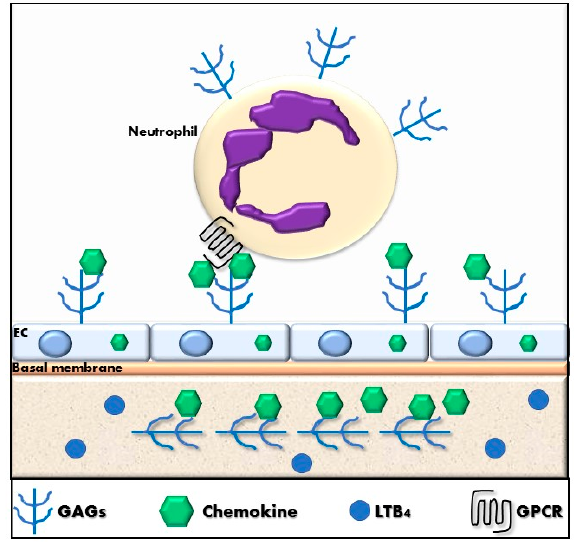
Figure 3. Neutrophil recruitment by chemokines and leukotriene B4. Neutrophils are recruited to the tissue through chemoattractants such as chemokines and LTB4. Chemokines bind to GAGs, which are expressed on endothelial cells and tissue. The retention of chemokines on GAGs generates a chemokine gradient that favors the binding of chemokines to their GPCR. LTB 4 binds to specific GPCRs on the neutrophil to induce firm adhesion of the cell to the endothelium. GAGs: glycosaminoglycans, LTB 4 : leukotriene B 4 , GPCR: G protein-coupled receptor.